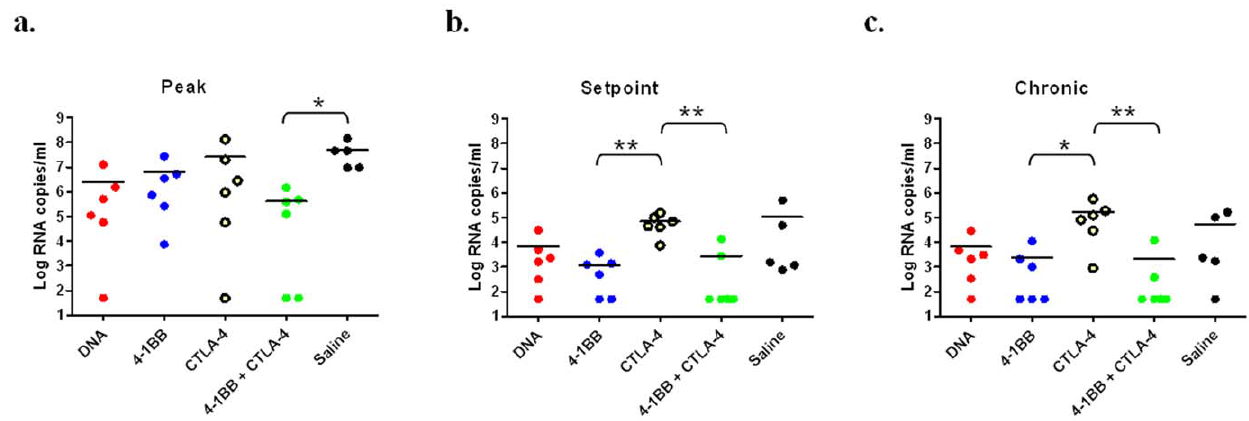
Figure 6. Modulation of the 4-1BB pathway during vaccination results in enhanced control of viral replication following SIVmac251 mucosal challenge. To test the efficacy of the vaccine-induced immune response the animals were challenged with a high-dose, intrarectal SIVmac251 challenge ten months following the fifth immunization. We then assessed viral loads every week for two months and every month thereafter up to 5 months post-challenge. The viral load data were graphed with the group means shown. (a). Viral loads were compared at peak viremia (2 weeks post challenge), (b.) set point (12 weeks post-challenge) and (c.) during chronic infection (20–24 weeks post-challenge). Statistical analysis was performed by log transforming the viral loads to normalize the data and used in a one-way ANOVA with a Tukey post-hoc test with p values of , 0.05 (*) or , 0.01 (**) indicated.